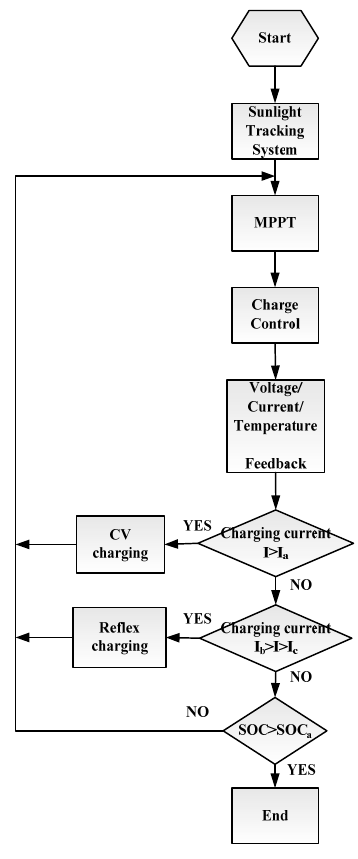
Figure 2. Solar charge control system flow chart.